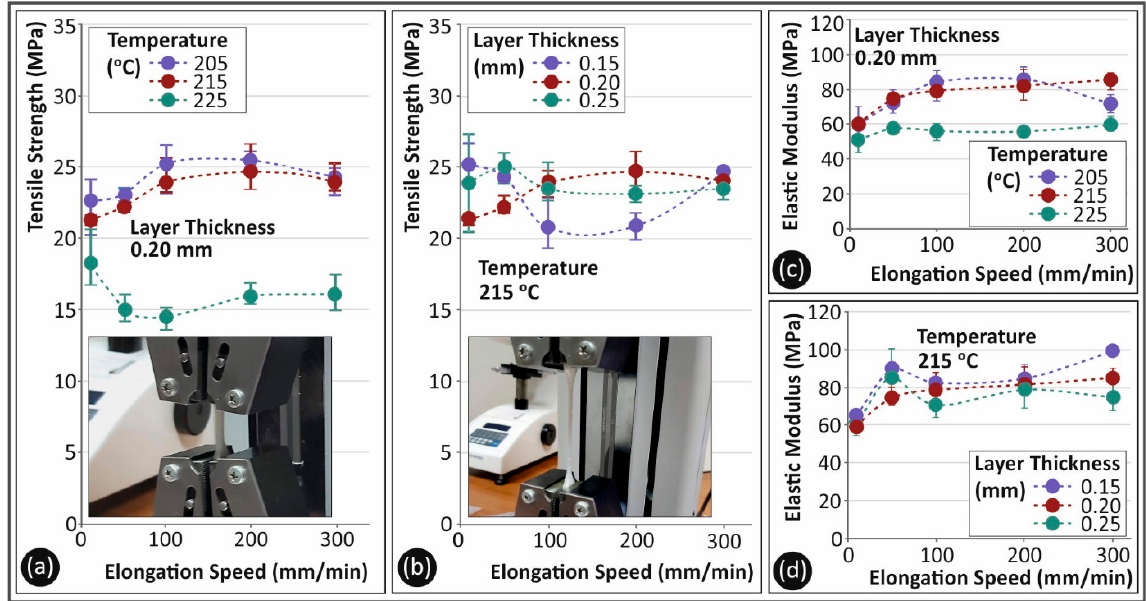
Figure 6. ( a , b ) Average tensile strength (MPa) and ( c , d ) average tensile elastic modulus (MPa) to elongation speeds (mm/min) for TPU material as follows: ( a , c ) 3D printing temperatures; ( b , d ) layer heights.